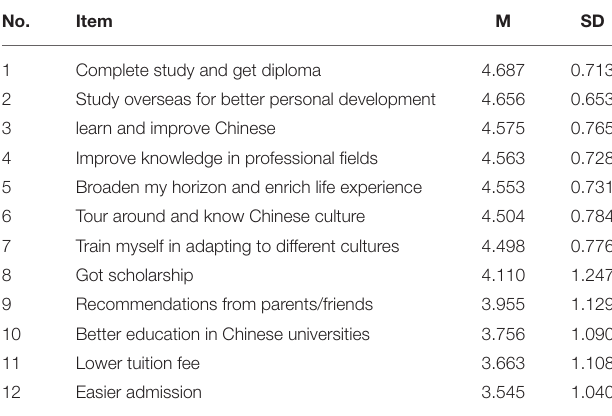
TABLE 3 | International students’ motivations to China ( N =